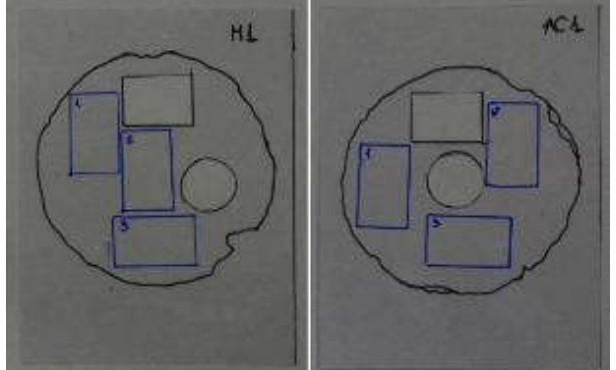
Figure 2. Examples of two measuring templates: the black rectangle corresponds to the stereoscopic microscopy analysis; the circle corresponds to the measurements taken with the spectrophotometer and the blue rectangles correspond to the Scotch Tape Test.